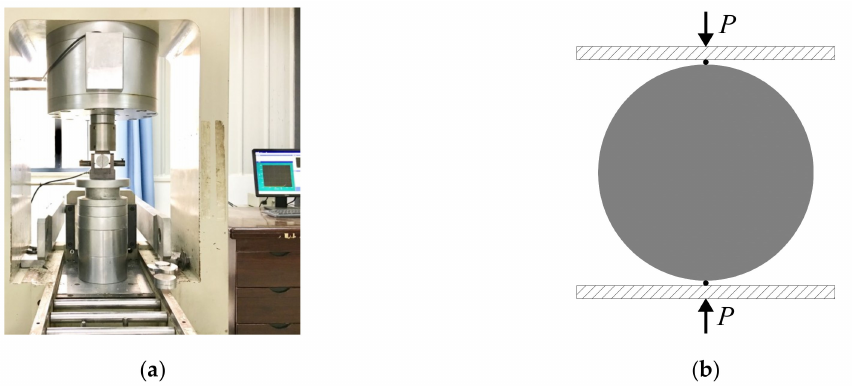
Figure 4. Brazilian disc splitting test. ( a ) BD splitting system; ( b ) Schematic of BD